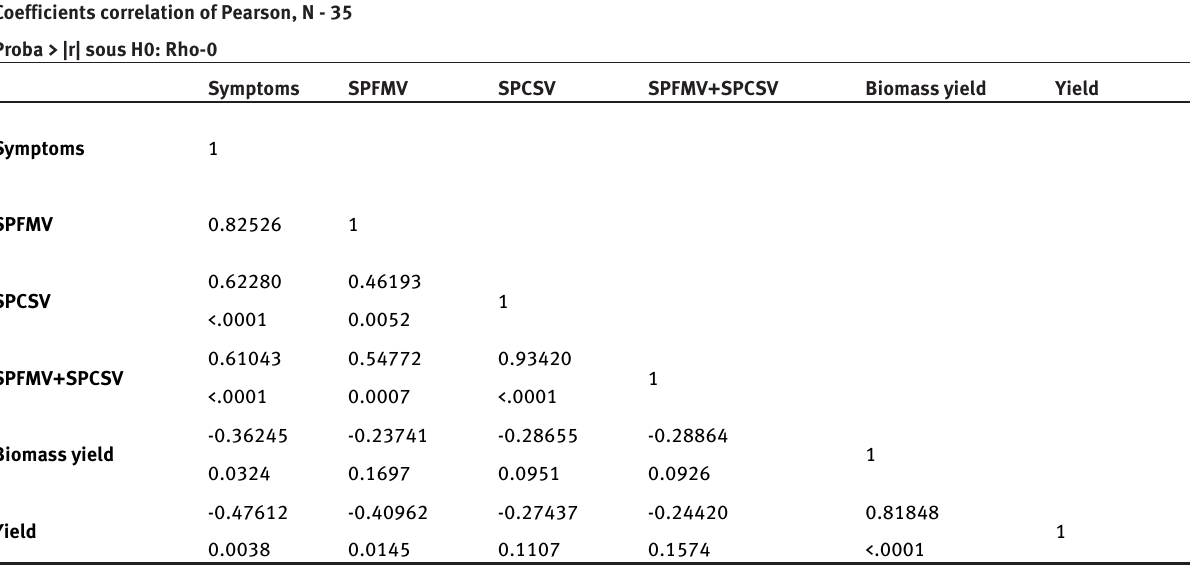
Table 3: The Pearson correlation coefficients showed significant positive correlations between symptoms, viruses, upper ground biomass and root yield Coefficients correlation of Pearson, N -